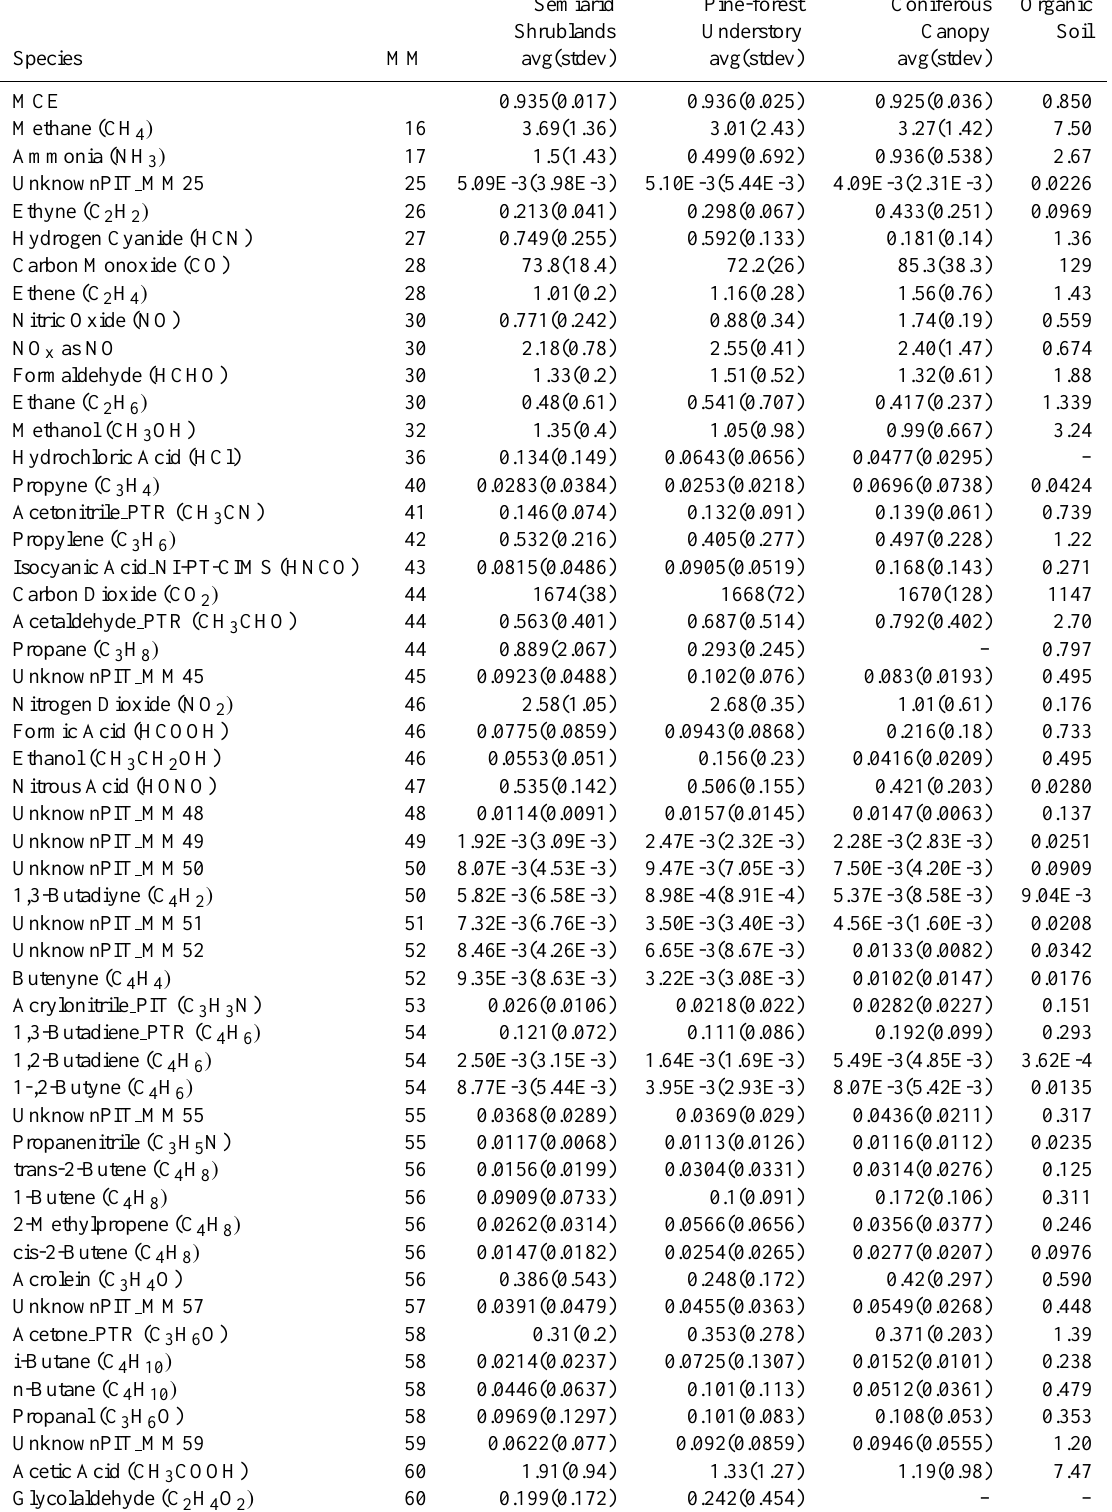
Table 2. Best estimate emission factors (g kg − 1 ) for four types of fire: prescribed fires in semiarid shrubland and pine-forest understory, and burning coniferous canopy or organic soils (see text for